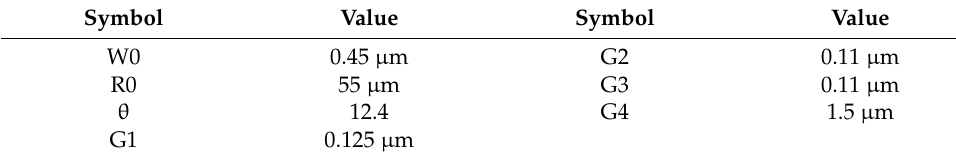
Table 1. Key parameters of the initial